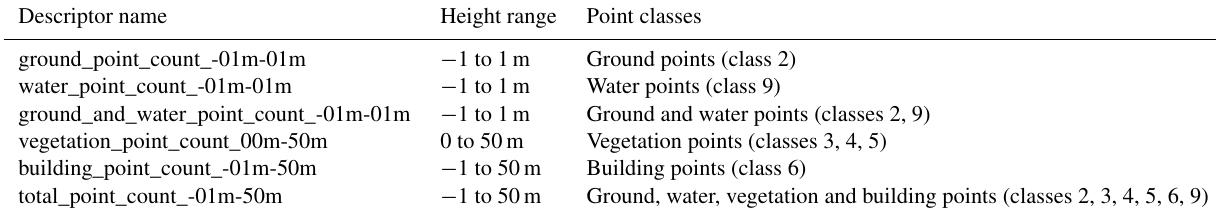
Table 3. General point-count descriptors, as well as the height ranges and point classes included in each descriptor. Descriptor name